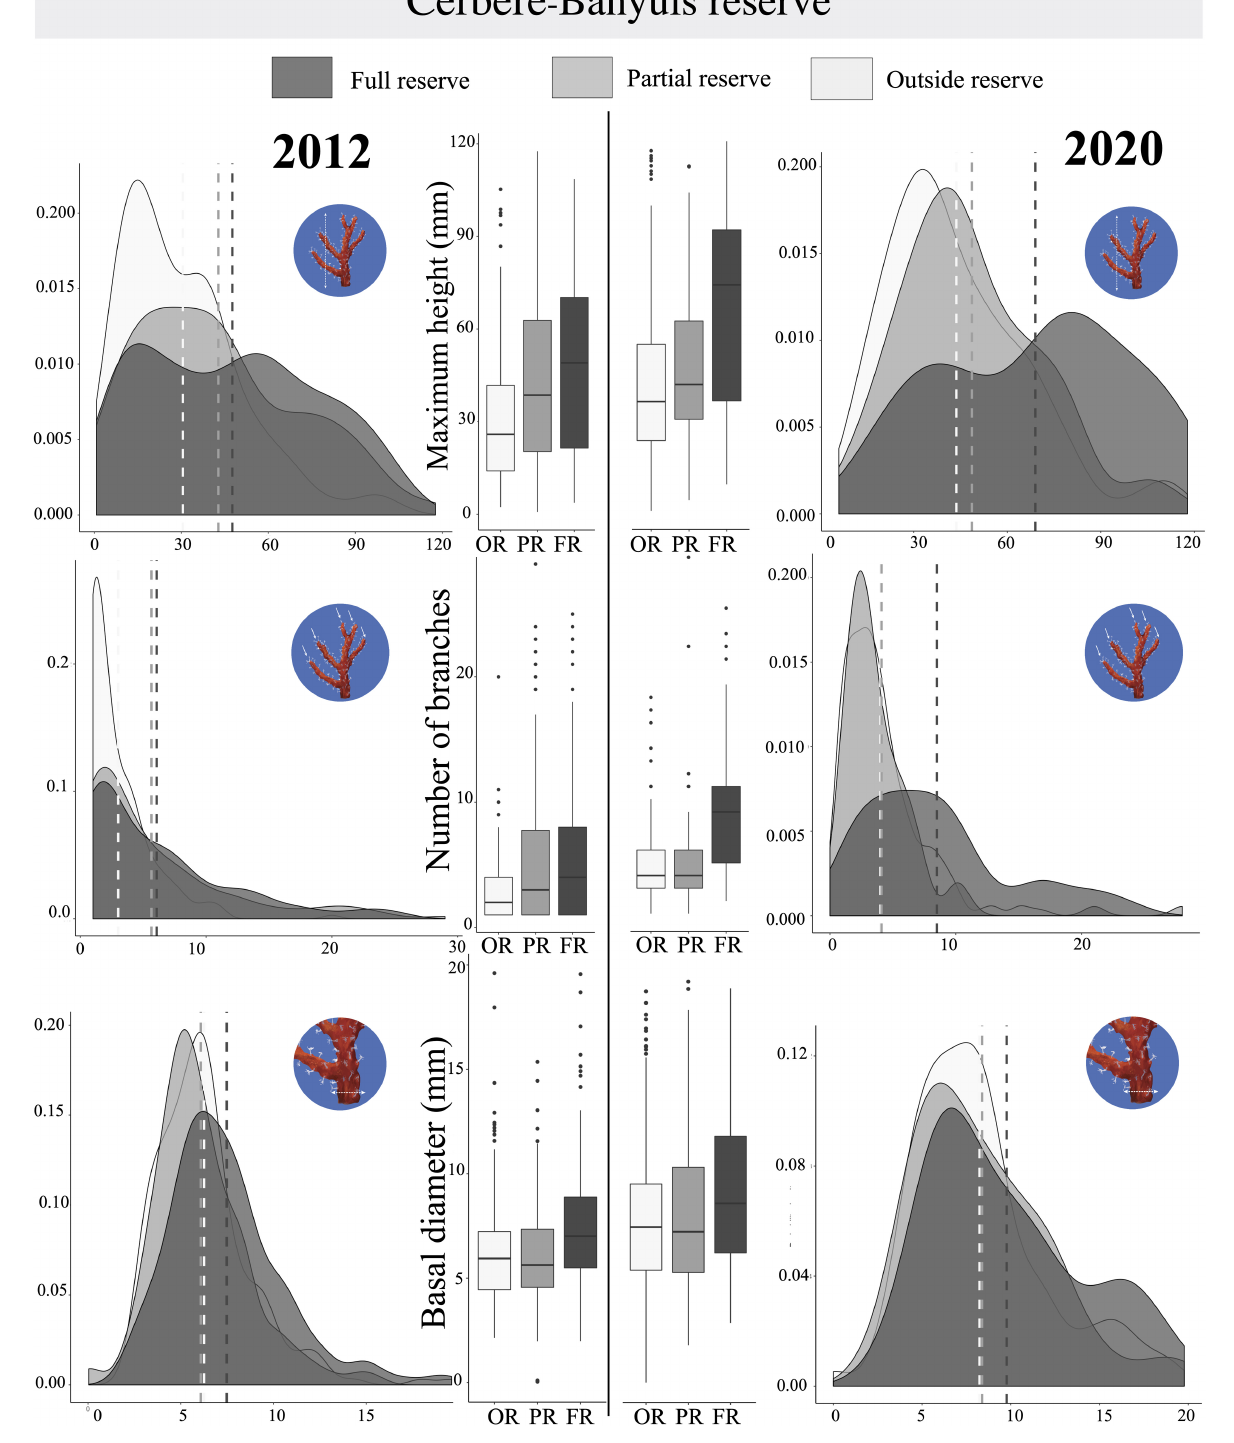
Frontiers in Marine Science |